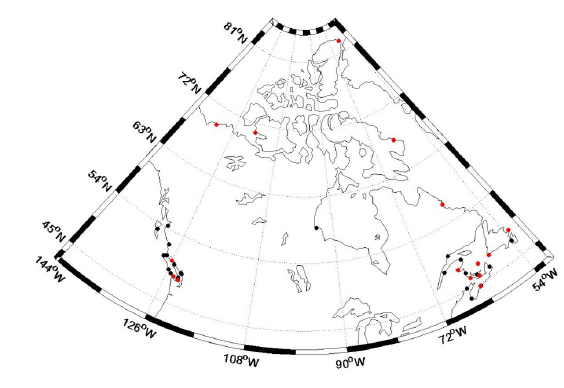
Figure 1. Geographical distribution of tide gauges in Canada used for W 0 computation (Red: Tide gauge stations with data gaps Black: Tide gauge stations without data